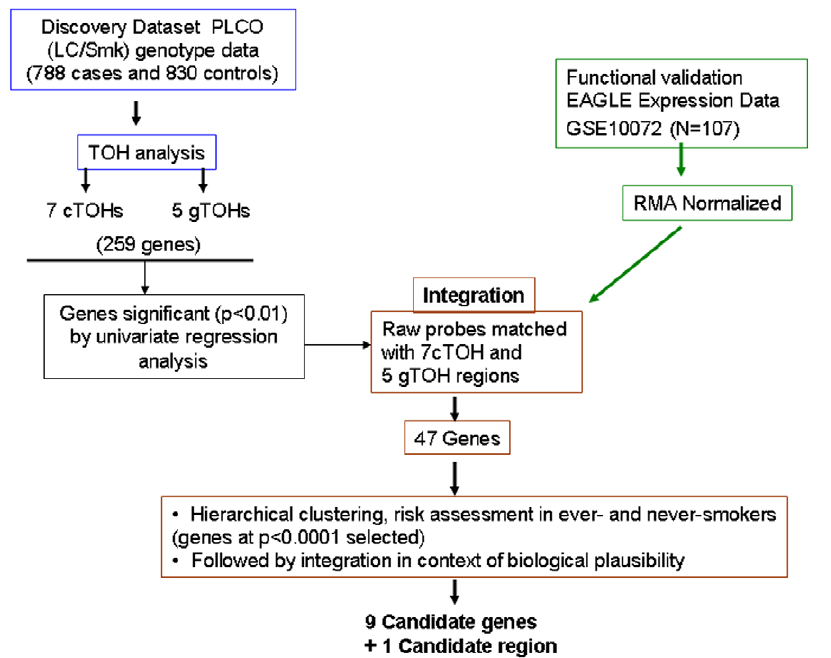
Figure 1. Study schema for the identification and functional genomic validation of significant cTOH and aTOH regions that are over- or under-represented in lung cancer cases. The schema represents the framework used to identify and subsequently integrate significant cTOHs and aTOHs (from the PLCO lung cancer screening trial) with global transcriptome datasets comparing lung cancers to normal lungs (from the EAGLE lung cancer screening trial). Multiple differentially expressed genes within the cTOHs and aTOHs had their candidacy prioritized initially based on statistical significance followed by biological plausibility (eg, relevant mouse models, reported to be somatically altered in sporadic lung cancers, relevant signaling pathways, etc) to finally obtain 9 ‘‘most plausible’’ candidate genes and one candidate genomic region. The latter is so designated because it was independently derived (by this current study) and subsequently found to overlap with the region previously identified in 3 previous studies as associated with lung cancer risk.